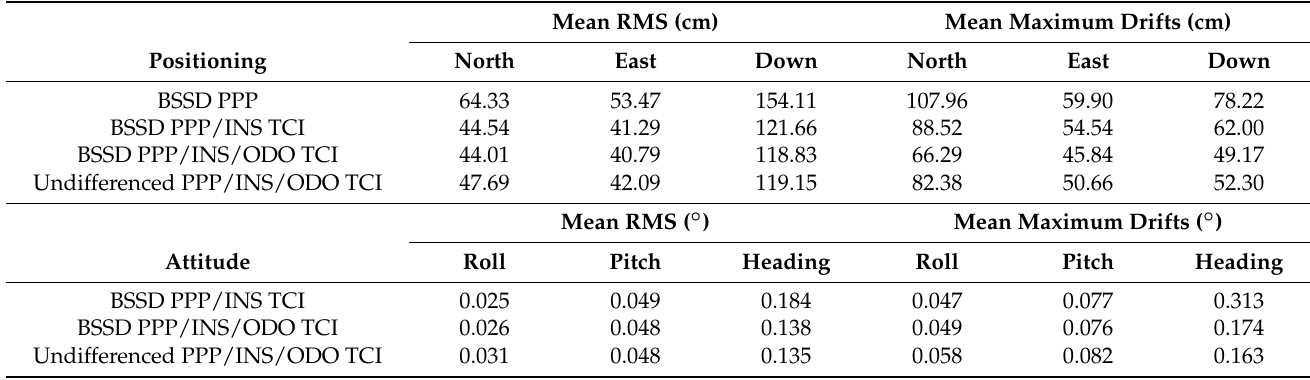
Table 7. Statistic of position and attitude